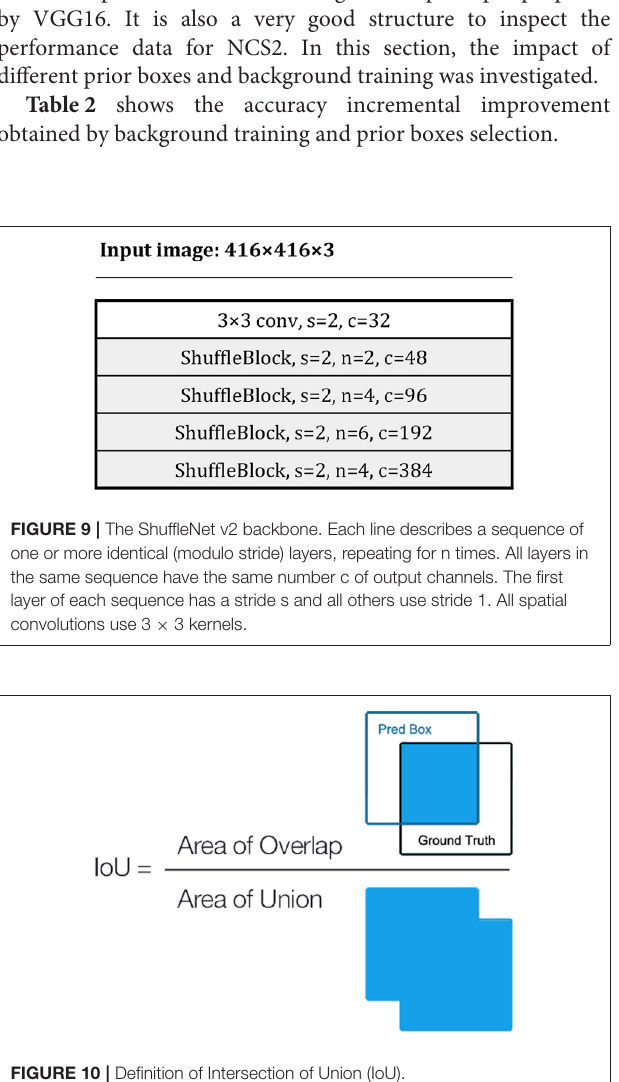
FIGURE 10 | Definition of Intersection of Union (IoU).